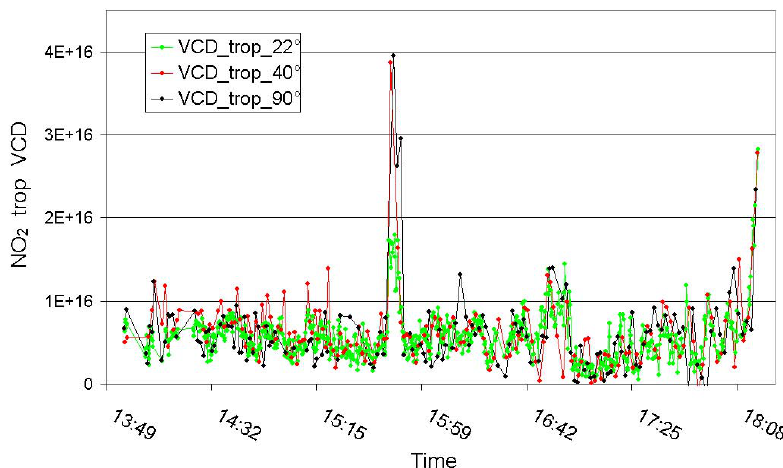
Fig. 4. The tropospheric VCDs of NO 2 along the road from Brussels to Heidelberg calculated according Eq. 11 from observations at different elevation